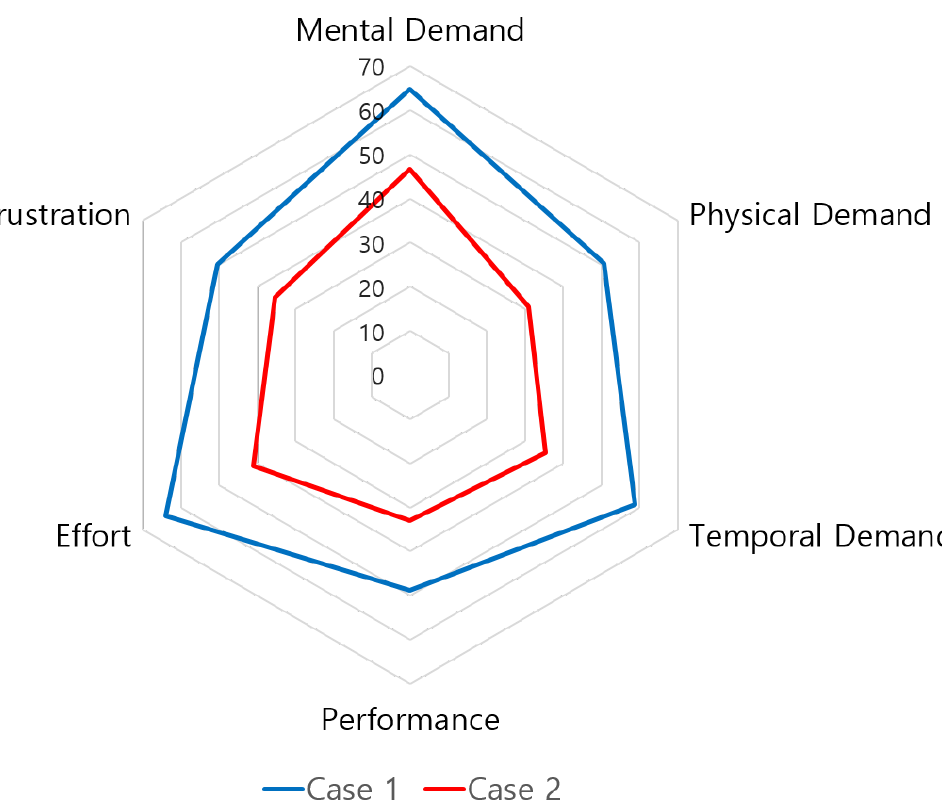
Figure 10. NASA-TLX measurement scores (Case 1: Position control and Case 2: Hybrid